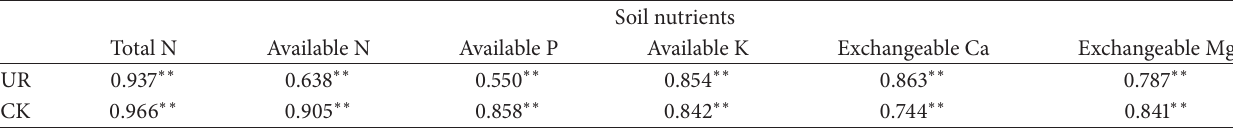
Table 5: Comparison of the correlation between SOC and soil nutrients in different stands. Soil nutrients Total N Available N Available P Available K Exchangeable Ca Exchangeable Mg UR 0.937